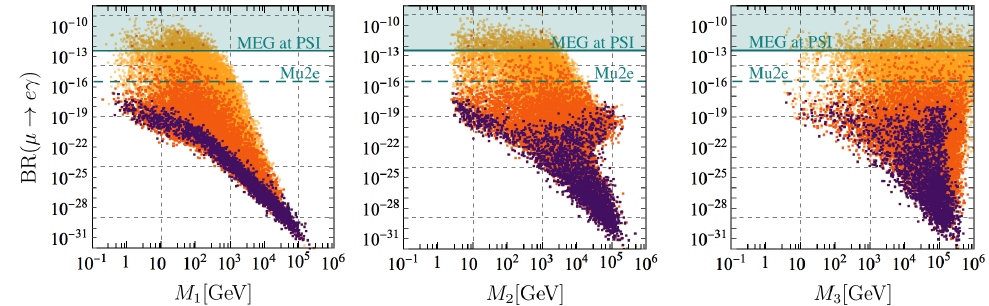
Figure 7 . The LFV observable BR ( µ → eγ ) versus the RH-neutrino masses. Here we have taken into account the lower bound of [0 . 1 – 1] GeV on the right handed Majorana neutrino masses arising from Big Bang Nucleosynthesis (BBN) [88]. The colours correspond to those of the most restrictive case of figure 5 (bottom